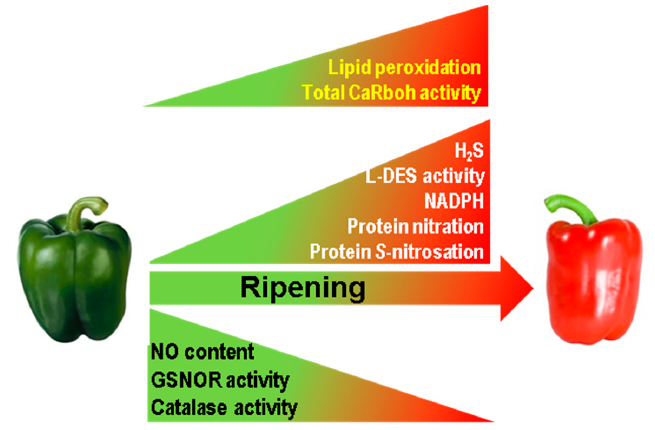
Figure 5. Reactive oxygen species (ROS) and reactive nitrogen species (RNS) metabolism during sweet pepper ( Capsicum annuum L.) fruit ripening. In the model previously reported [20,36] it has been incorporated the total superoxide-generating CaRboh activity as well as the content of lipid peroxidation both increasing in red ripe fruits as reported in this work. GSNOR, nitrosoglutathione reductase. H 2 S, hydrogen sulfide. L-DES, L-cysteine